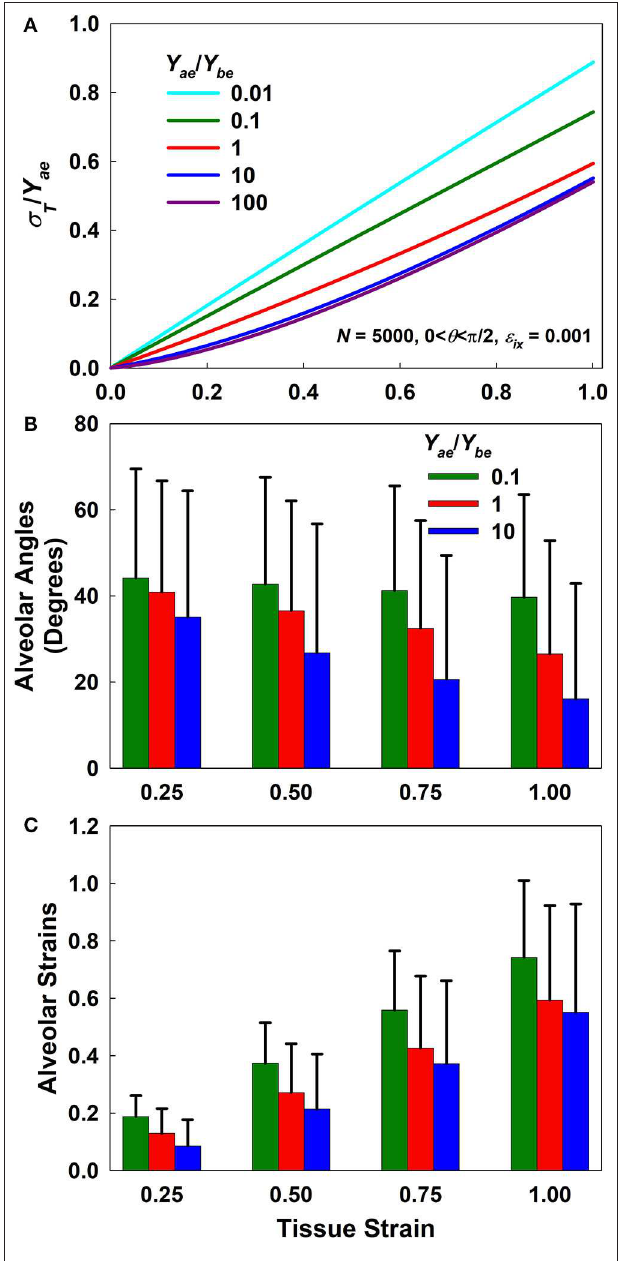
FIGURE 2 | Forward simulation results. (A) Normalized stress-strain curves for different Y ae / Y be ratios. (B,C) Mean and standard deviation of alveolar angles and strains, respectively, as a function of macroscopic tissue strain for Y ae / Y be ratios of 0.1, 1, and 10. Alveolar angles at a strain of zero were uniformly distributed between 0 and π /2 while alveolar strains were set to zero.